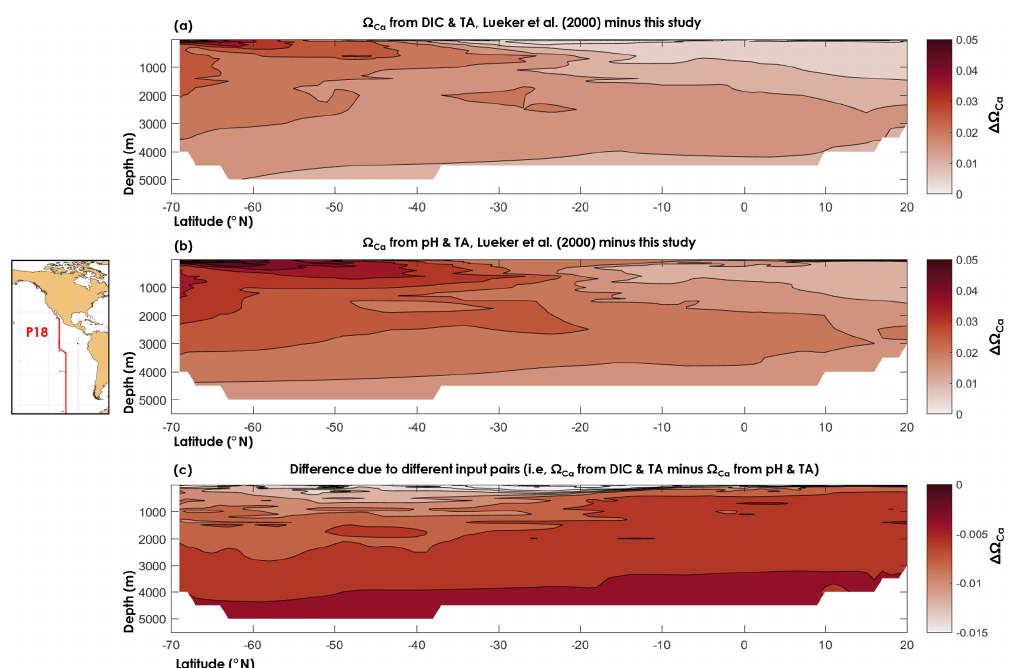
Figure 8. Difference between (a) the calcite saturation state ( (cid:127) Ca ) computed from TA and DIC using the dissociation constants of Lueker et al. (2000) and the constants derived from this study, (b) (cid:127) Ca computed from pH and TA using the dissociation constants of Lueker et al. (2000) and the constants derived from this study, and (c) (cid:127) Ca computed from the DIC and TA pair and the pH and TA pair and the dissociation constants derived from this